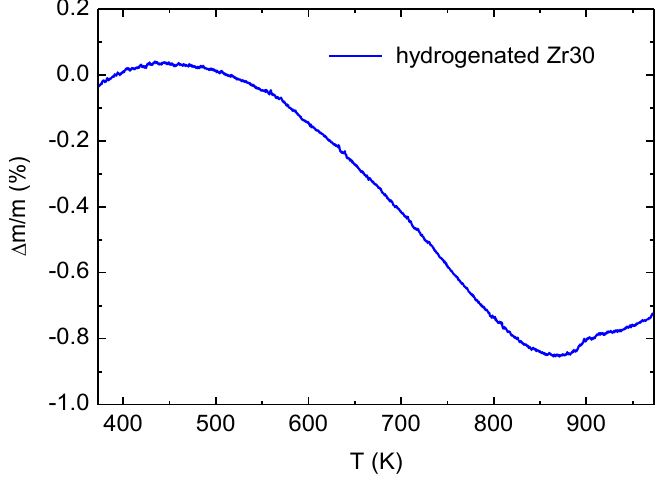
Figure 4. TGA scan of the hydrogenated Zr30